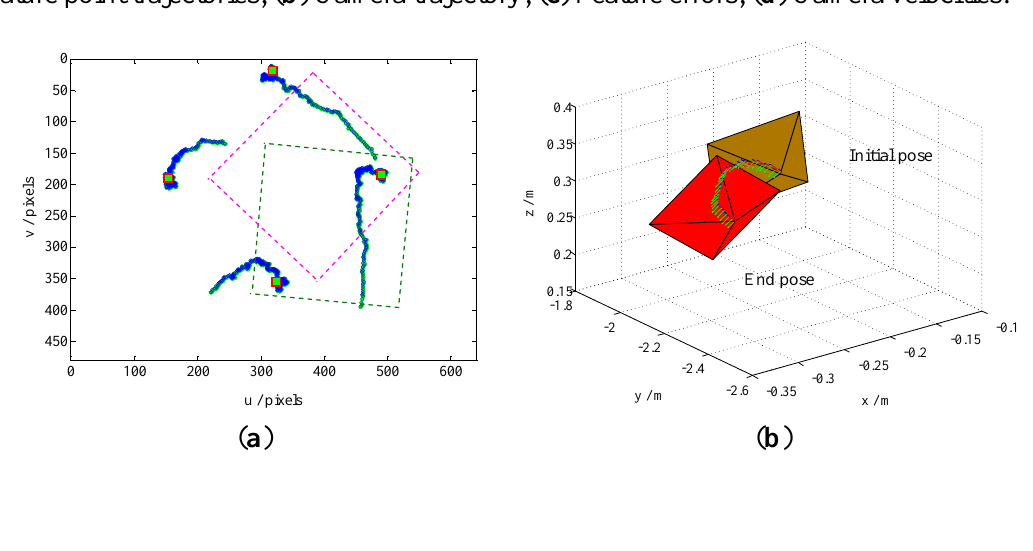
Figure 14. Experimental results obtained by our method for Case 1 rotational movement. ( a ) Feature point trajectories; ( b ) Camera trajectory; ( c ) Feature errors; ( d ) Camera